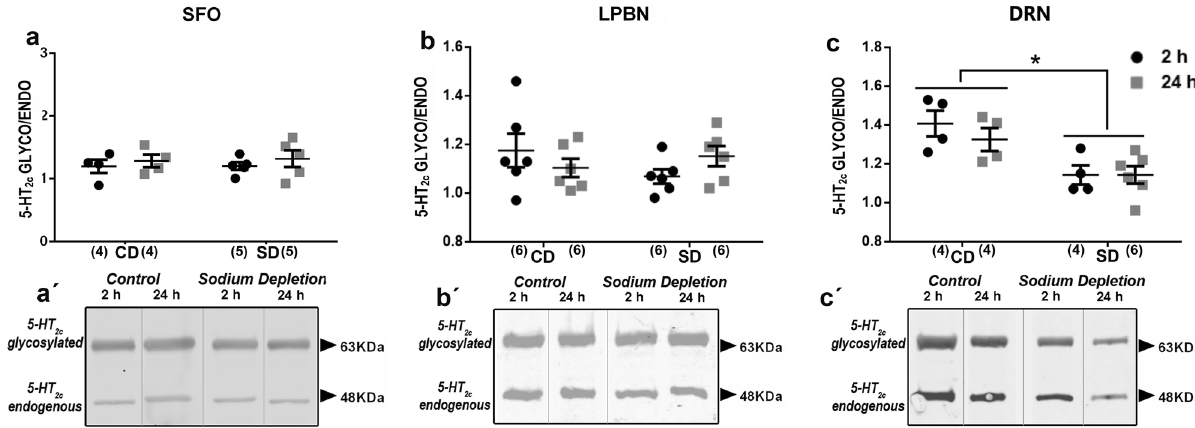
Figure 5. Glycosylation of 5HT2c receptors after sodium depletion. 5-HT 2C receptor glycosylate/endogenous relationship in SFO ( a ), LPBN ( b ), DRN ( c ) at two and 24 h after sodium depletion. Western blot detection of glycosylated and endogenous 5HT 2C receptor protein expressed in SFO ( a’ ), LPBN ( b’ ) and DRN ( c´ ). Values are mean ± SE (number of cases indicated by the individual points in each case). * p < 0.05 significant difference between SD versus CD. SD: Sodium-depleted group. CD: Control group. SFO: Subfornical Organ. LPBN: Lateral Parabrachial Nucleus. DRN: dorsal raphe nucleus. Blots: Dividing grey lines indicated non-contiguous lanes from different parts of the same gel. Full-length blots are presented in Supplementary Figure